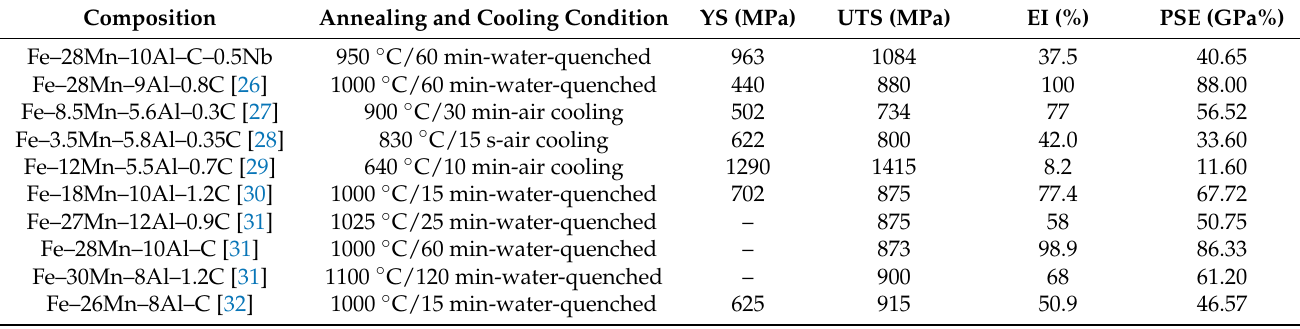
Figure 8. ( a ) SEM and ( b ) TEM micrographs of the Fe – 12Mn – 5.5Al – 0.7C steel, showing ferrites and κ -carbides at the boundaries of austenite grains in [27].